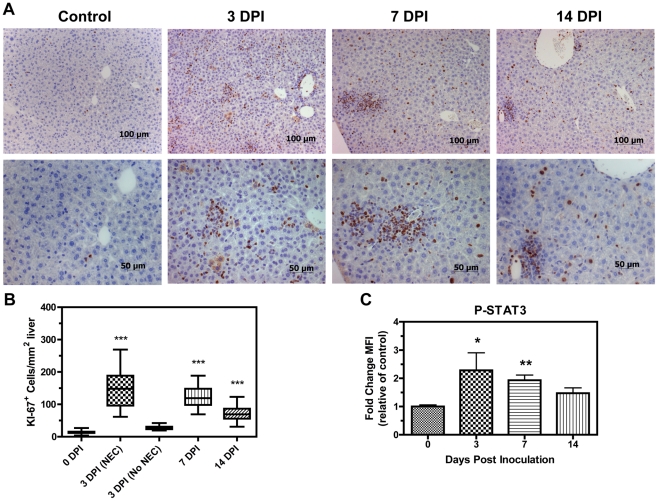

C. rodentium significantly increases Ki-67+ labeling index and STAT3 phosphorylation in livers.(A) Top panels are 200× and lower panels are 400× views of the same frame. Brown-colored pigment indicates positively stained cells for Ki-67. (B) Average number of Ki-67+ cells/mm2 liver determined in 15 fields (magnification, 400×, 3 fields/lobe) per mouse (n = 3 for 0, 7, and 14 DPI; n = 2 for 3 DPI (NEC); n = 1 for 3 DPI (No NEC)). Data is represented as box-whisker plots, where boxes represent the first to third quartile and a horizontal line indicates the median. Bars represent ranges. (One-way ANOVA with Tukey's multiple comparison test: *** P<0.001). (C) P-STAT3 levels in liver lysates were detected using a Bio-Rad phosphoprotein panel and expressed as a fold change of mean fluorescence intensity (MFI) relative to controls (0 DPI). STAT3 was significantly activated in livers of mice inoculated with C. rodentium at 3 and 7 DPI (Kruskal-Wallis test with Dunn's multiple comparisons test: * P<0.05, ** P<0.01).